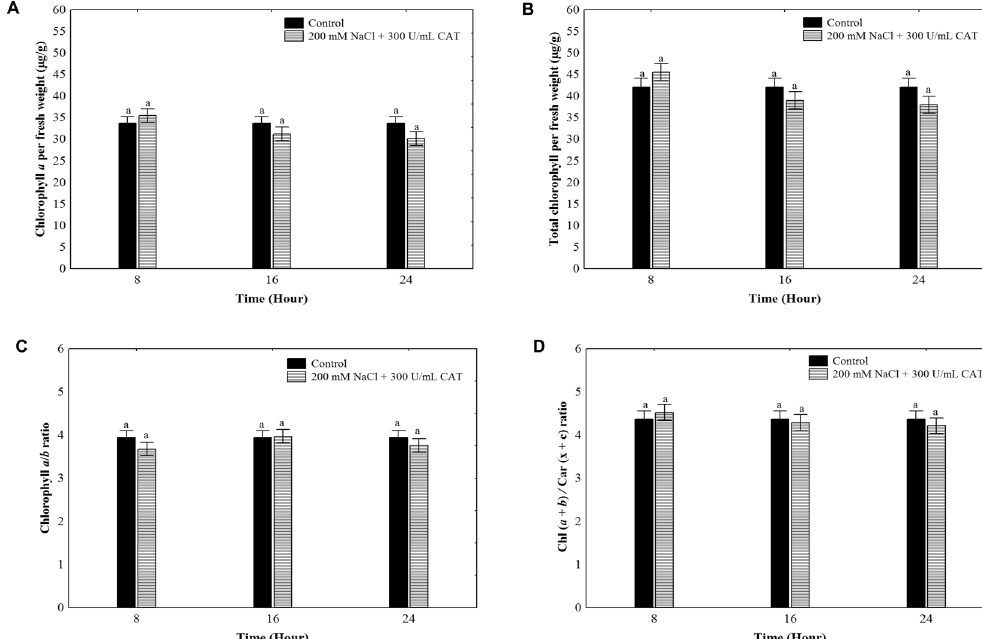
Figure 8. Effects of exogenous CAT application on chlorophyll and carotenoids content in Opuntia streptacantha cladodes exposed to 200 mM NaCl. ( A ) Chlorophyll a . ( B ) Total chlorophyll ( a + b ). ( C ) Chlorophyll a / b ratio. ( D ) Chl ( a + b )/Car (x + c) ratio. Values are means and bars indicate ± SD, ( n = 9). Different letters indicate significant difference between treatments and time (hours) according to Duncan’s multiple range tests at P <